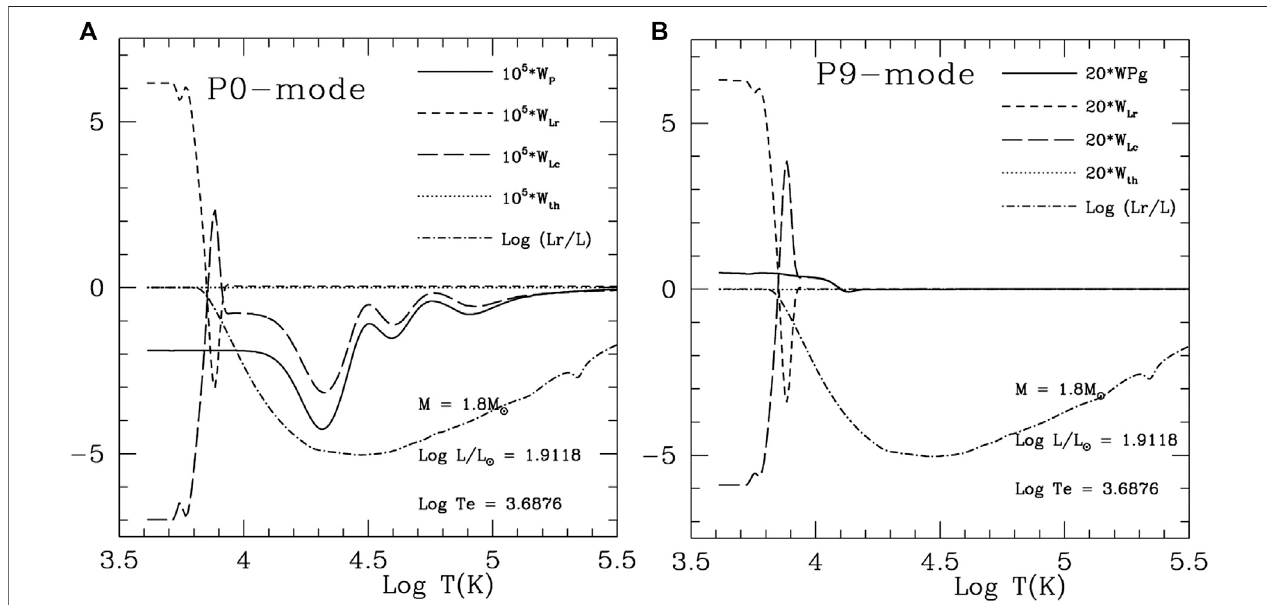
FIGURE 3 | Gas pressure ( W pg ) , radiative fl ux ( W Lr ) , convective fl ux ( W Lc ) , and buoyancy work and turbulent dissipation components ( W th ) of cumulative work as functions of log T for a low-luminosity red giant. W pg (cid:2) W Lr + W Lc + W th (see Eqs. 10 – 13 ). (A) The same as in Figure 1A : P0-mode, (B) The same as in Figure 1B :